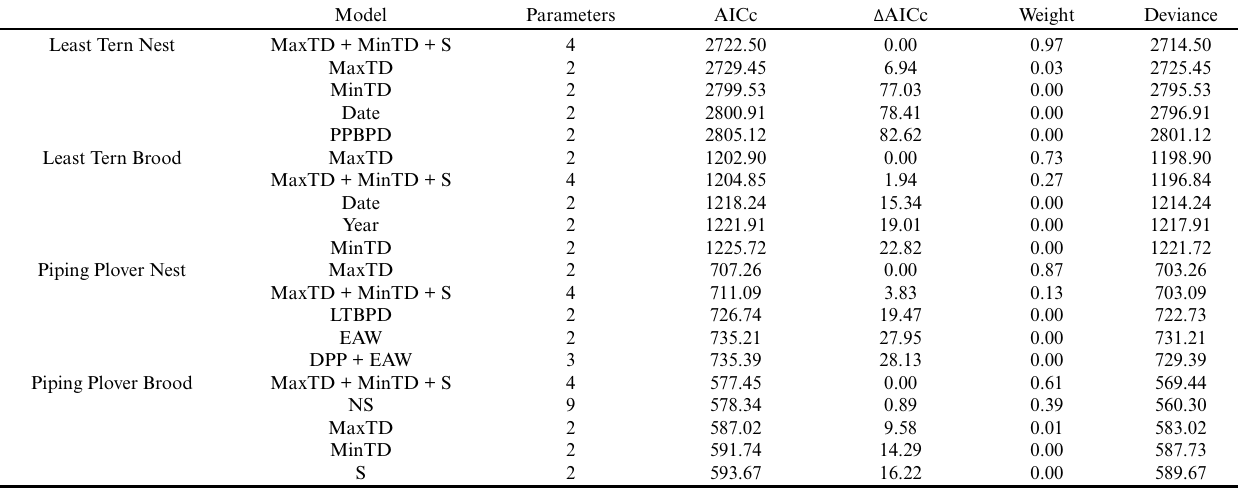
Table 3. Top five models, as ranked by AICc statistic, that best predict Interior Least Tern and Piping Plover nest and brood daily survival rates at nine managed off-channel sites in the Associated Habitat Reach, 2001–2015. Variables included nest site (NS), Interior Least Tern and Piping Plover breeding pair density (LTBPD and PPBPD, respectively), initiation date (Date), year, standard deviations from average maximum temperature (MaxTD), standard deviations from average minimum temperature (MinTD), storm events (S), elevation above water (EAW), and distance to predator perch (DPP).